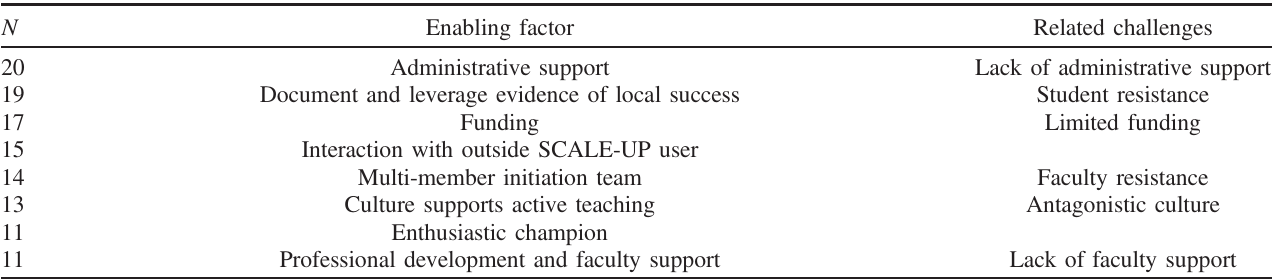
TABLE I. Summary table of key factors surrounding implementation. N is the number of implementations mentioning the factor as either an important enabler or challenge (out of 21 initiation